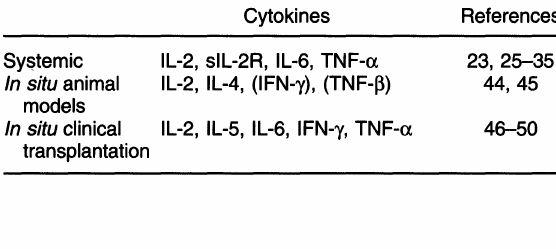
Table 2. Detection of cytokines implicated in allograft rejection